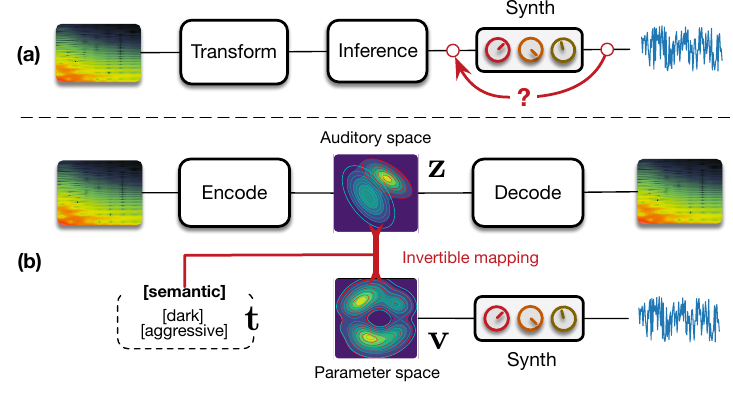
Figure 1. Universal synthesizer control . ( a ) Previous methods perform direct parameter inference from the audio, which is inherently limited by the non-differentiable synthesis operation and provides no higher-level form of control. ( b ) Our novel formulation states that we should first learn an organized and compressed latent space z of the synthesizer’s audio capabilities, while mapping it to the space v of its synthesis parameters. This provides a deeper understanding of the principal dimensions of audio variations in the synthesizer, and an access to higher-level